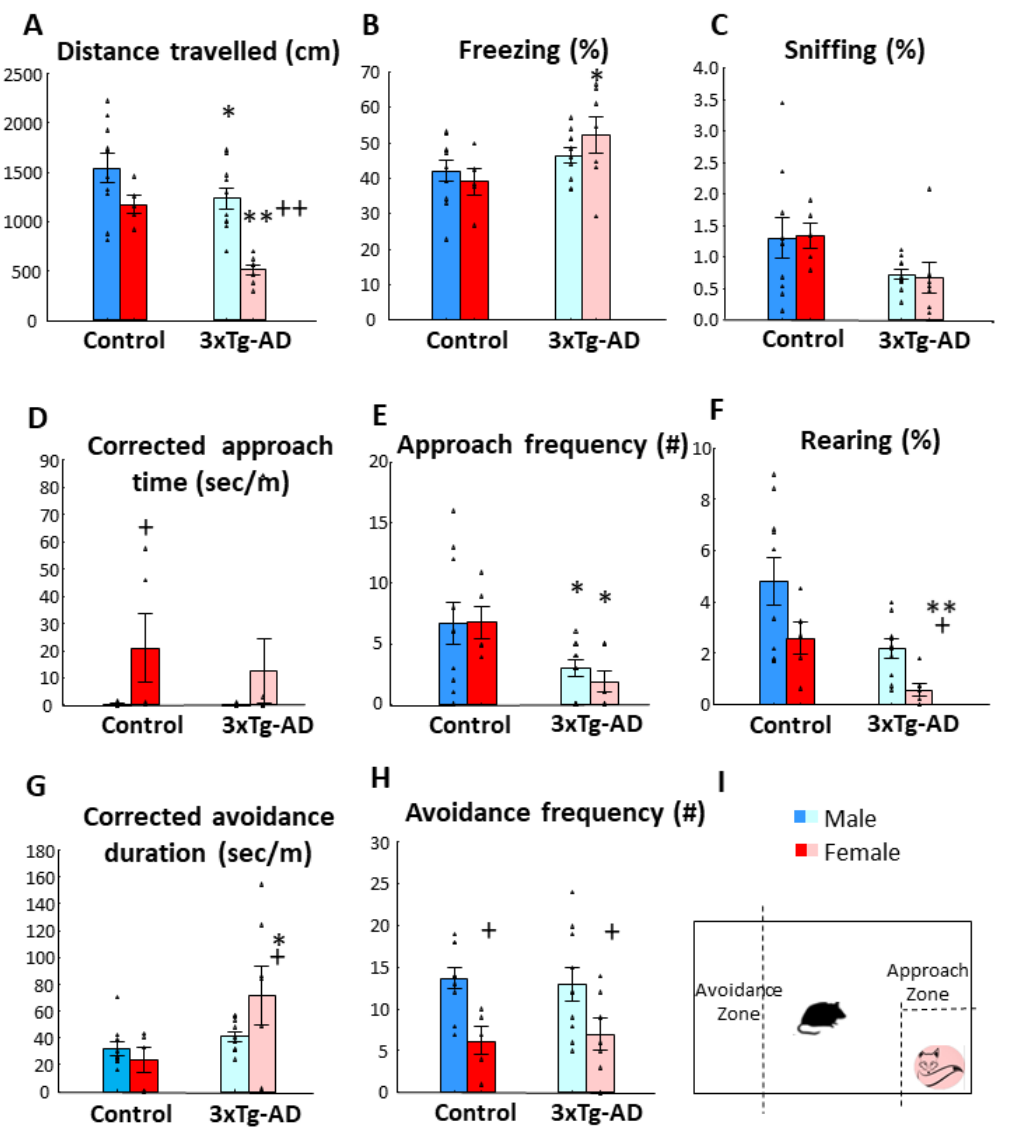
Figure 3. Fox odor avoidance behavior in 15-month-old male and female animals. ( A ) Distance traveled in centimeters during 10 min. The 3xTg-AD moved significantly less than the control group ( p < 0.01). Additionally, the female moved less ( p < 0.01) compared to males irrespective from their genotype. ( B ) Time spent freezing in percentage of 10 min observation period. The 3xTg-AD animals displayed increased freezing ( p < 0.05). ( C ) Time spent sniffing on the fox odor container. The 3xTg- AD animals spent less time sniffing ( p < 0.01) without sex difference. ( D ) Corrected approach time to fox odor zone. The female animals investigated the approached zone longer than males ( p < 0.05). ( E ) Number of approaches to the odor zone. The 3xTg-AD group displayed lower frequency than the control group ( p < 0.05). ( F ) Rearing activity. The 3xTg-AD reared less than controls ( p < 0.05). ( G ) Corrected time spent in the avoidance zone. The 3xTg-AD animals spent more time in the avoidance zone than their age matched controls ( p = 0.01). ( H ) Number of entries into the avoidance zone. The female animals entered into the avoidance zone less often ( p = 0.01). No significant genotype x sex interaction was observed in any of the investigated parameters. ( I ) Schematic representation of the fox odor test. Data are shown as the mean ± SEM. The individual raw data points are represented as triangles. * p < 0.05, ** p < 0.01 vs. Control; + p < 0.05, ++ p < 0.01 vs. Male. # = amount of approach and/or avoidance